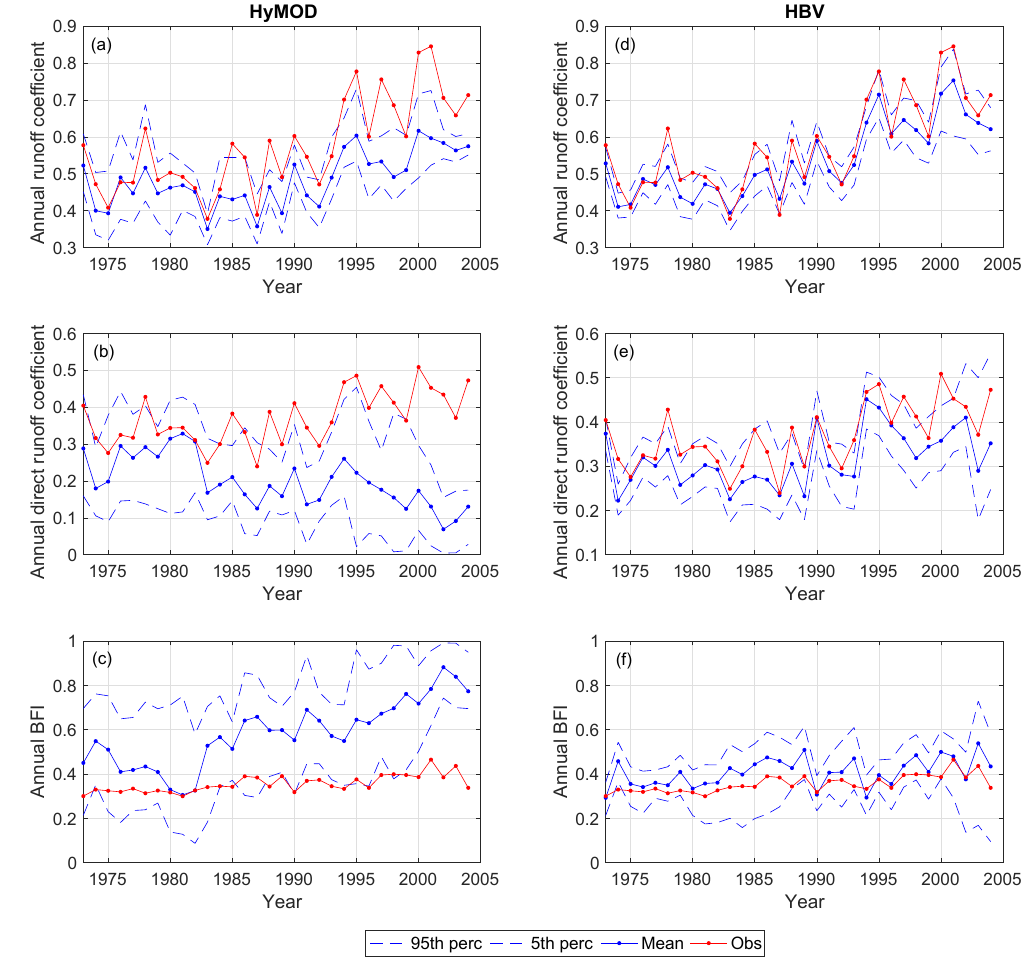
Figure 7. Influence of time-varying parameters on model output (i.e., without state updating) summarized in terms of the annual runoff coefficient (top row), annual direct runoff coefficient (second row) and annual baseflow index (BFI) (third row). Results for HyMOD are shown in the first column, and results for HBV are shown in the second